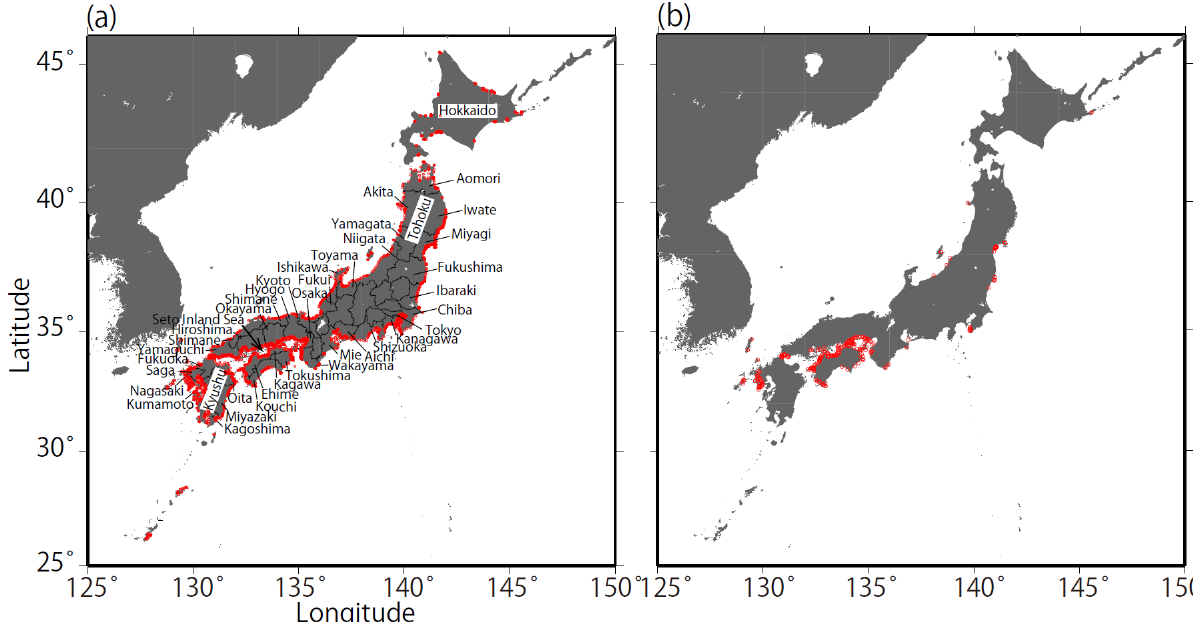
Figure 1. Coastal maps and monitoring sites in Japan. Red points in (a) indicate the fixed sites ( n = 1481) monitored by the Regional Development Bureau of the Ministry of Land, Infrastructure, Transport, and Tourism and the Ministry of the Environment (Japan) under the WPCL monitoring program. (b) Monitoring sites that met the strictest criterion ( n =